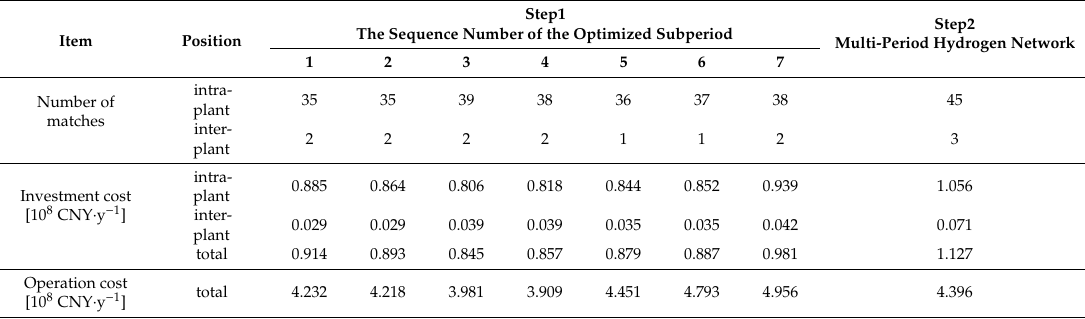
Step2 Multi-Period Hydrogen Network